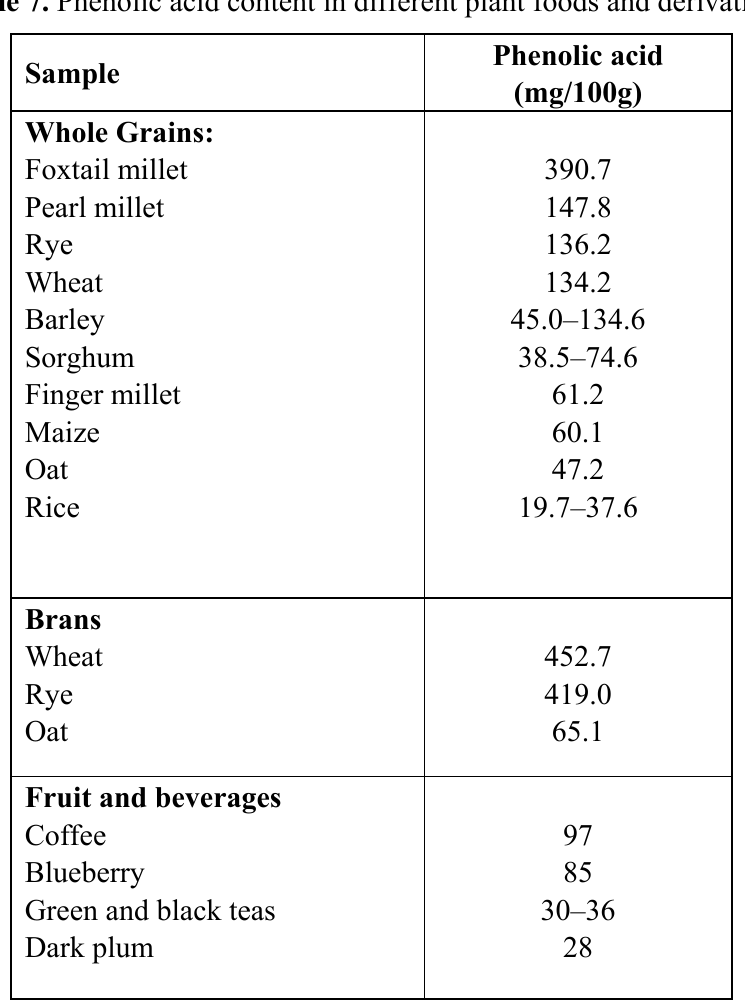
Table 7. Phenolic acid content in different plant foods and